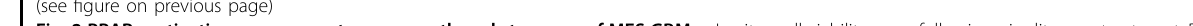
Fig. 2 PPAR γ activation suppresses tumor growth and stemness of MES GBM. a In vitro cell viability assay following pioglitazone treatment. PN or MES GSCs were treated with 3 or 10 μ M pioglitazone for 7 days, which was followed by MTS assays of cell viability. Values are the mean ± SEM ( n = 3). Asterisks are references as follows: ** P < 0.01, and **** P < 0.0001 (one-way ANOVA, Tukey ’ s post hoc test). b PPAR γ suppression of MES GSC stemness. Stemness was assessed by limiting dilution assays (left) and sphere forming assays (right) following pioglitazone treatment for 14 days. Stem cell frequency was calculated as described in the methods. Values are the mean ± SEM ( n = 3). Asterisks are references as follows: ** P < 0.01, *** P < 0.001, and **** P < 0.0001 (Student ’ s t test). c STAT3 signaling responsive to PPAR γ activa t ion in MES but not in PN GSCs. PN and MES GSCs were treated with 10 μ M pioglitazone for 48 h, which was followed by measuring the expression of pSTAT3 and target genes. Values are the mean ± SEM ( n = 3). d In vitro cell viability assay following PPAR γ knockdown. MES GSCs were transfected with a PPAR γ siRNA, and after 4 days MTS assays (left) or immunoblot assays (right) were performed to assess knockdown ef fi ciency. Values are the mean ± SEM ( n =